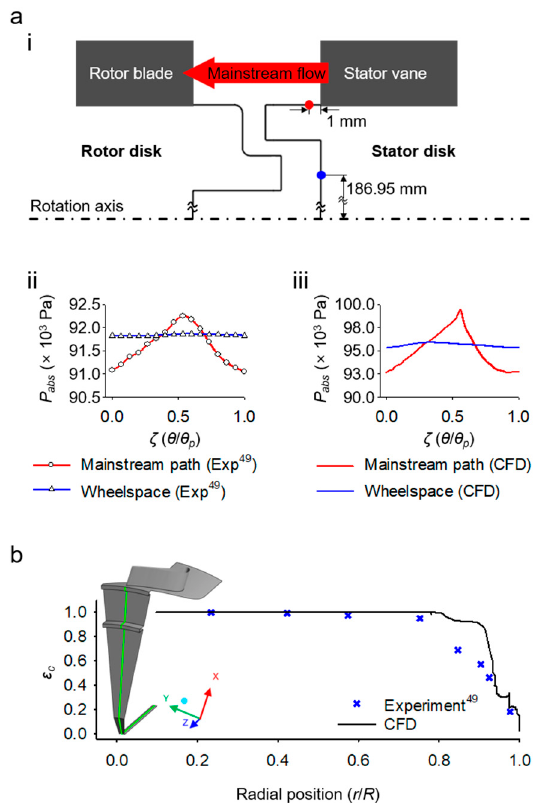
Figure 9. ( a ) Absolute pressure distribution. ( i ) Pressure measurement point of mainstream path (red point) and wheelspace (blue point). ( ii ) Absolute pressure distribution of experiment [24]. ( iii ) Absolute pressure distribution of CFD. ( b ) Sealing effectiveness along the mid-line (green line) of the stator disk.